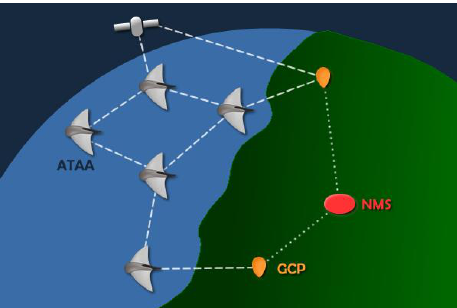
Figure 3. Permanent Installation of a DNIHSS using ATAA over the sea.